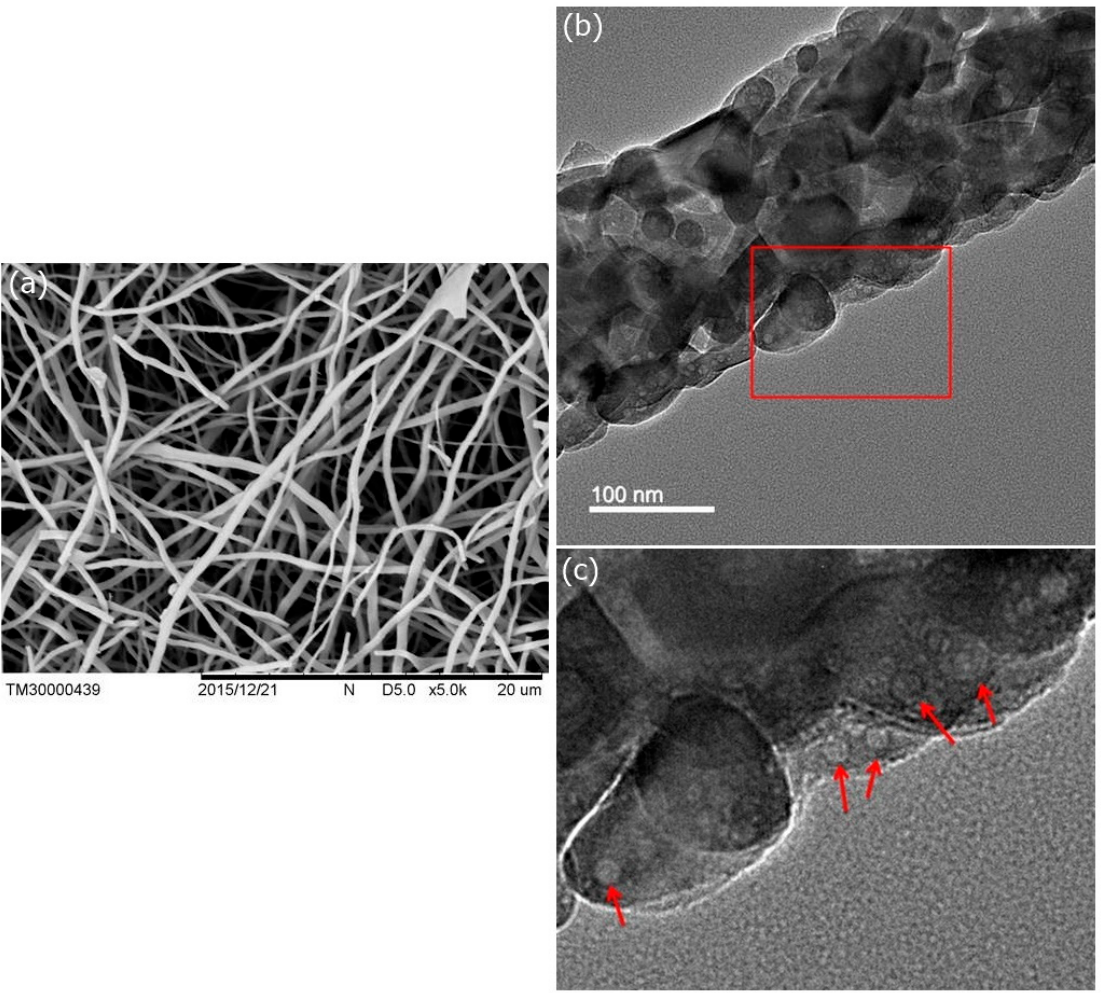
Figure 4. ( a ) SEM and ( b ) TEM micrographs of the nanofibers after heat treatment at 800 °C under an N 2 atmosphere. ( c ) an enlarged graph in red square of ( b ). The red arrows in ( c ) indicates mesopores within the nanocrystals.